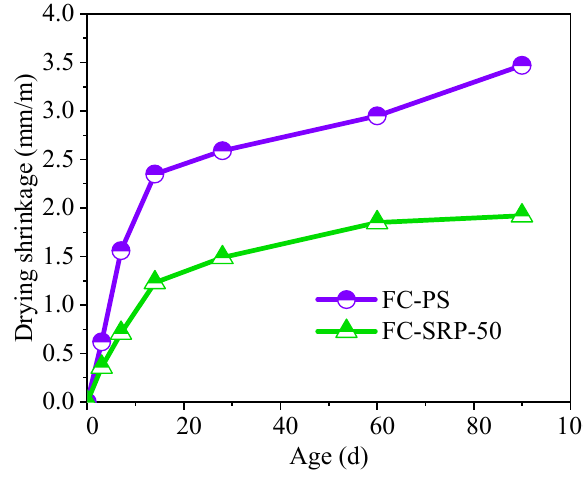
Figure 8. Compressive strength of foam concretes.